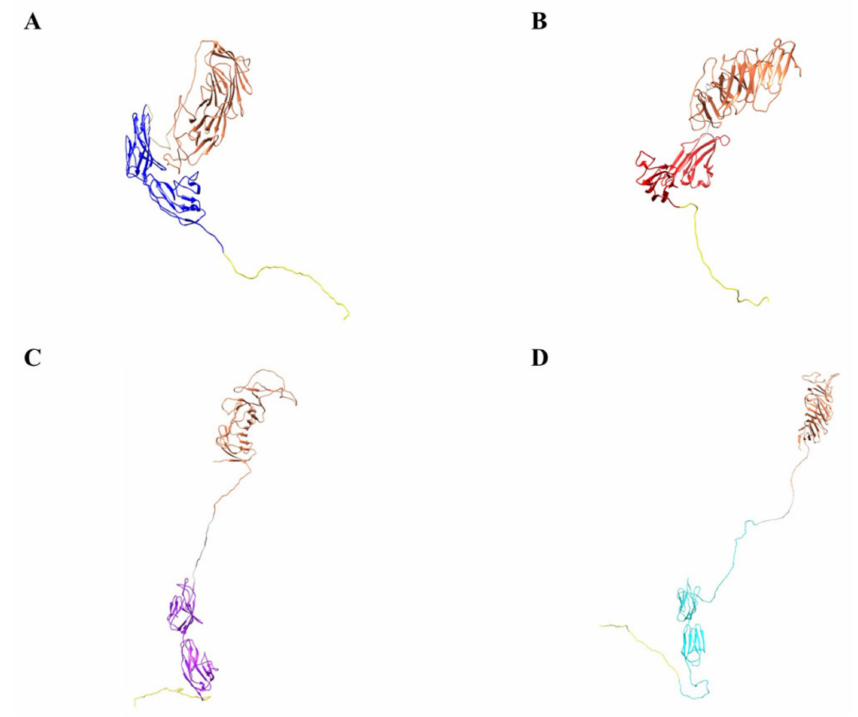
Figure 8. Computational models demonstrate modularity of metastasis-inhibiting protein. ( A ) CD19 (coral), GS linker (gray), JAM-A (blue), and pHLIP peptide (yellow). ( B ) CD19 (coral), GS linker (gray), JAM-B (red), and pHLIP peptide (yellow). ( C ) CD19 (coral), GS linker (gray), JAM-C (pur- ple), and pHLIP peptide (yellow). ( D ) CD19 (coral), GS linker (gray), JAM 4 (cyan), and pHLIP peptide